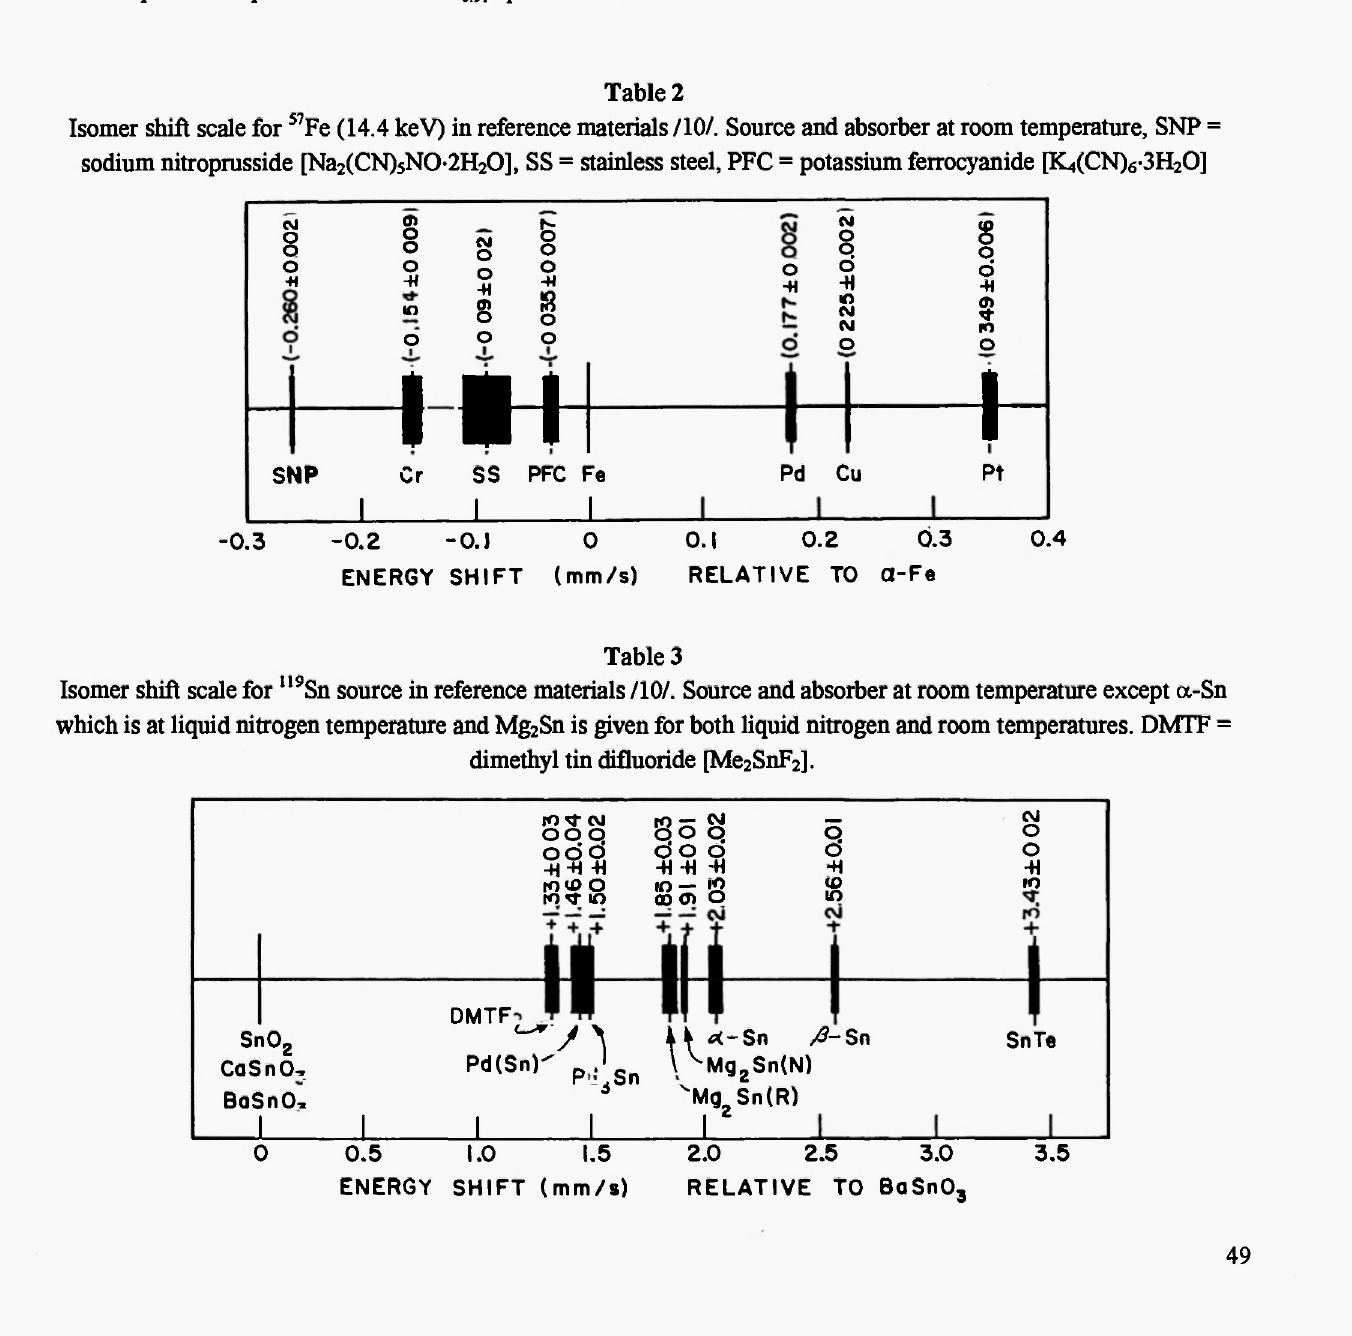
Fig. 2: Isomer shift. The effect of the electric monopole interaction on the nuclear levels and the resultant Mössbauer spectrum. Specimen was an FeN i sputtered film at 300 K. 0 9